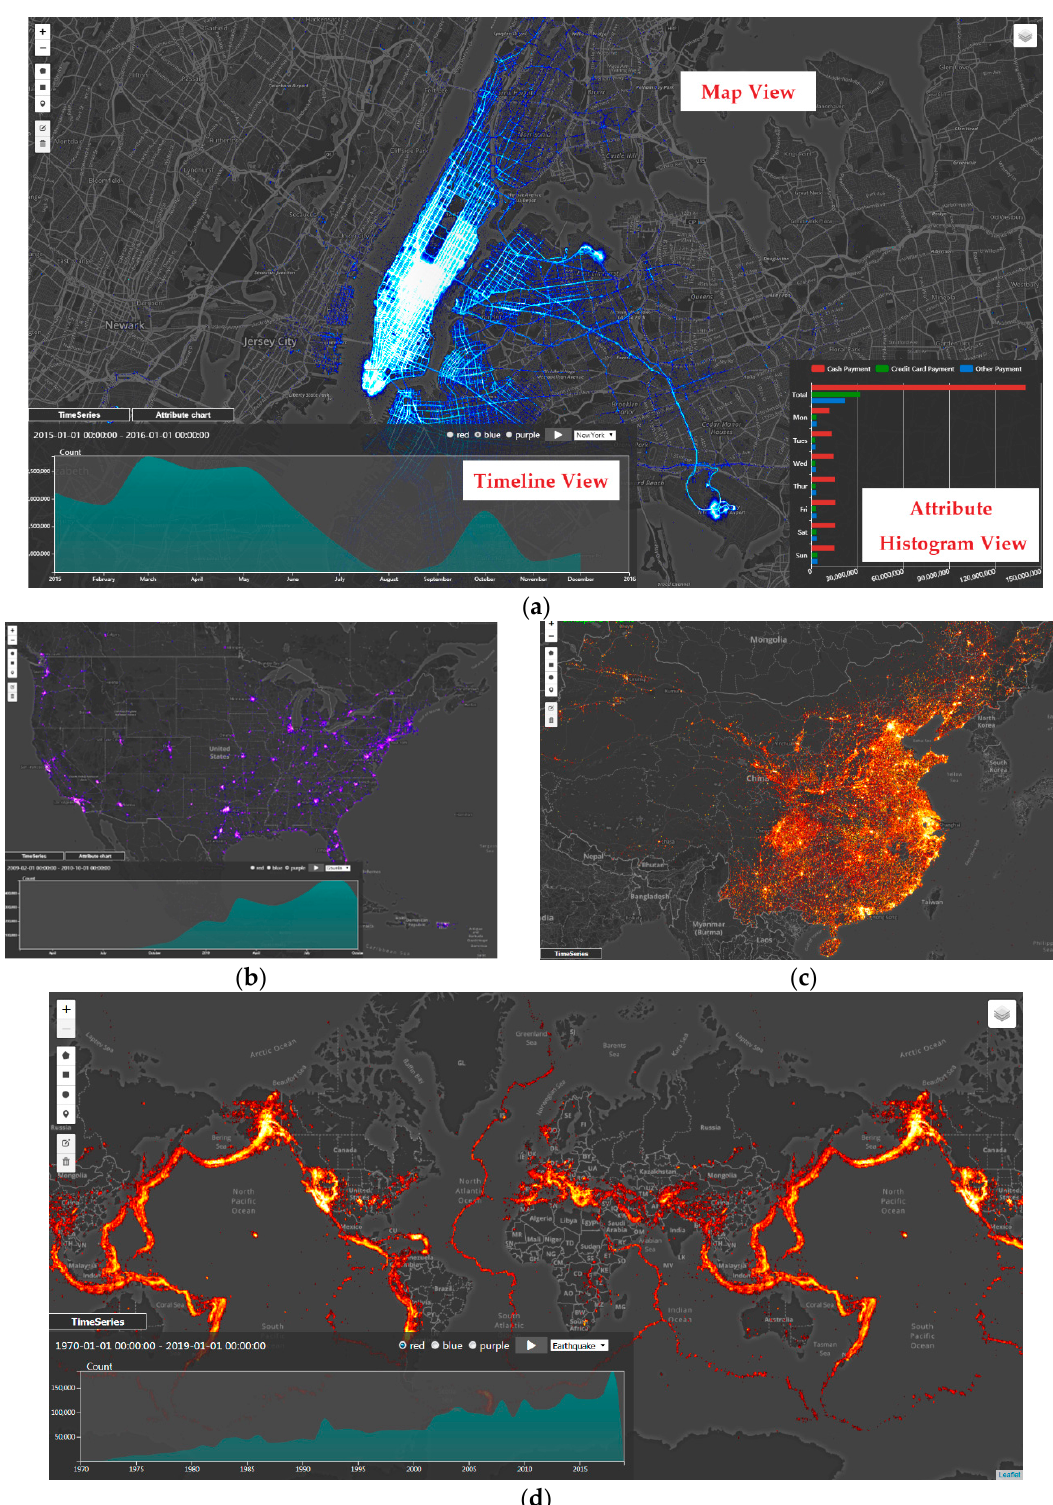
Figure 10. The MAP-Vis web visualization interface. ( a ) NYC Taxi; ( b ) BrightKite; ( c ) Chinese Enterprise Data; ( d ) Global